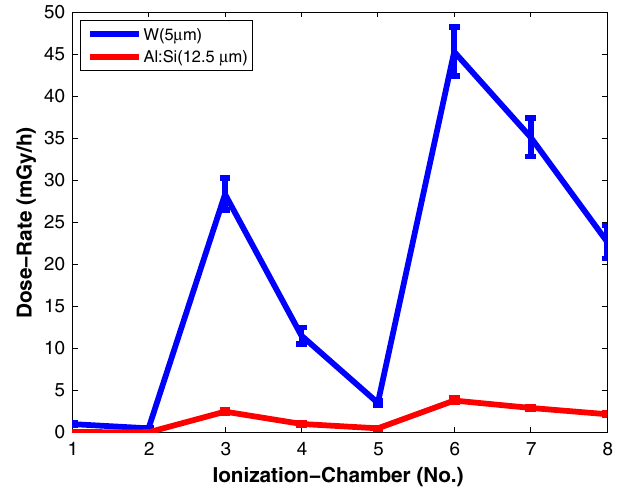
FIG. 18. Average radiation-dose rate (mGy = h) measured by the 8 ionization chambers (I-C) placed in the FERMI FEL1 undulator chain when scanning with 12 . 5 μ m Al ð 99 Þ ∶ Si ð 1 Þ wire and a 5 μ m tungsten wire — at a motor speed of 0 . 20 mm = s — an electron beam of 700 pC and energy of 1.325 GeV. The data in the plot result from the average — over 10 scans — of the dose- rate readout of the I-Cs integrated over 30 beam shots.